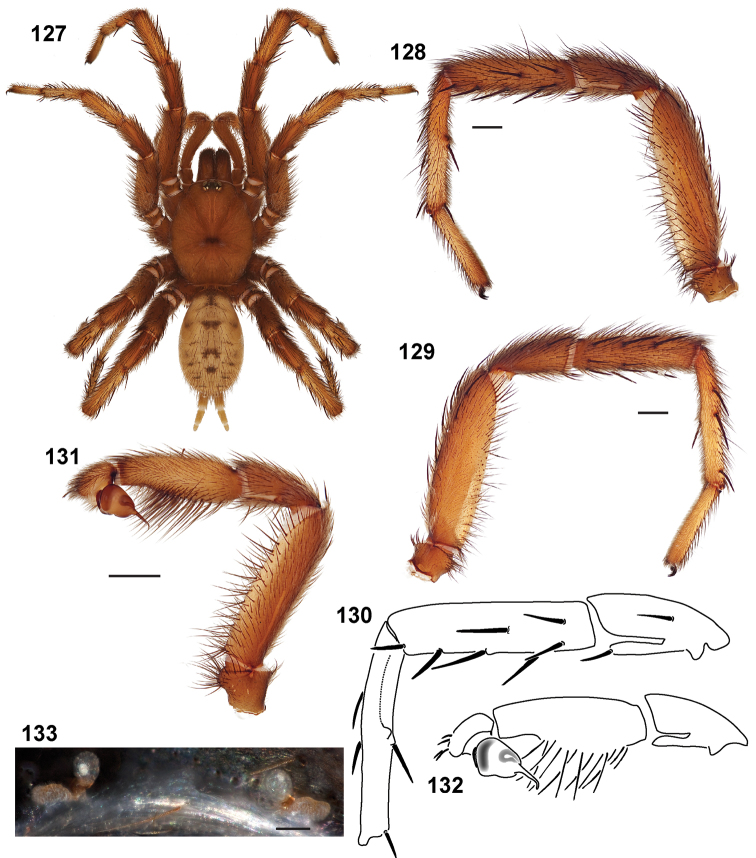
Aptostichus asmodaeus sp. n. from Contra Costa Co., Mt. Diablo. 127–132 male holotype (AP428); scale bars = 1.0mm 127 habitus [805850] 128–130 leg I 128 retrolateral aspect [805844] 129 prolateral aspect [805848] 130 line drawing of spination patterns on leg I, retrolateral aspect, tibia and metatarsus 131–132 pedipalp, retrolateral aspect of photograph [805852] and line drawing 133 cleared spermathecae (AP551) [806573]; scale bar = 0.1mm.